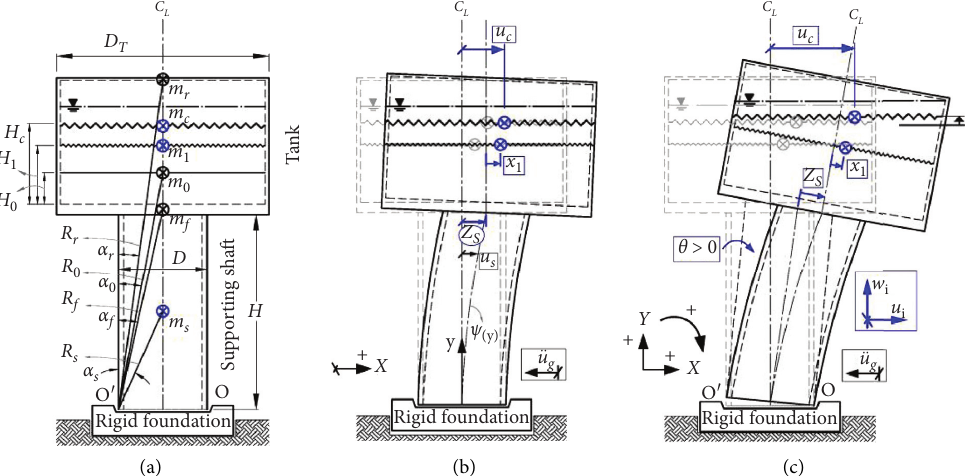
Figure 2: Configuration of rocking elevated tank model with isolation at the base (C1): (a) initial position; (b) preuplift phase of motion; (c) under rocking motion.